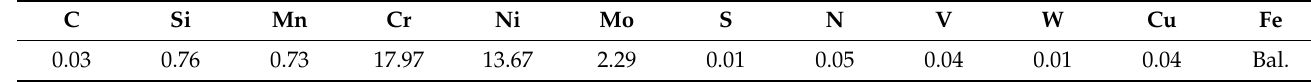
Table 2. Chemical composition of the printed 316L SS parts.